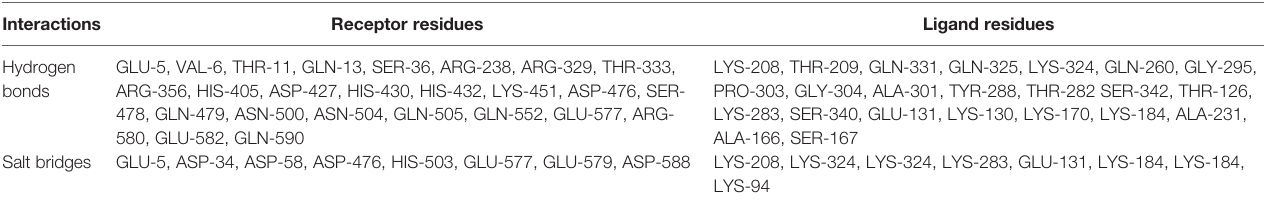
TABLE 3 | List of residues involved in forming polar interaction and salt bridges.